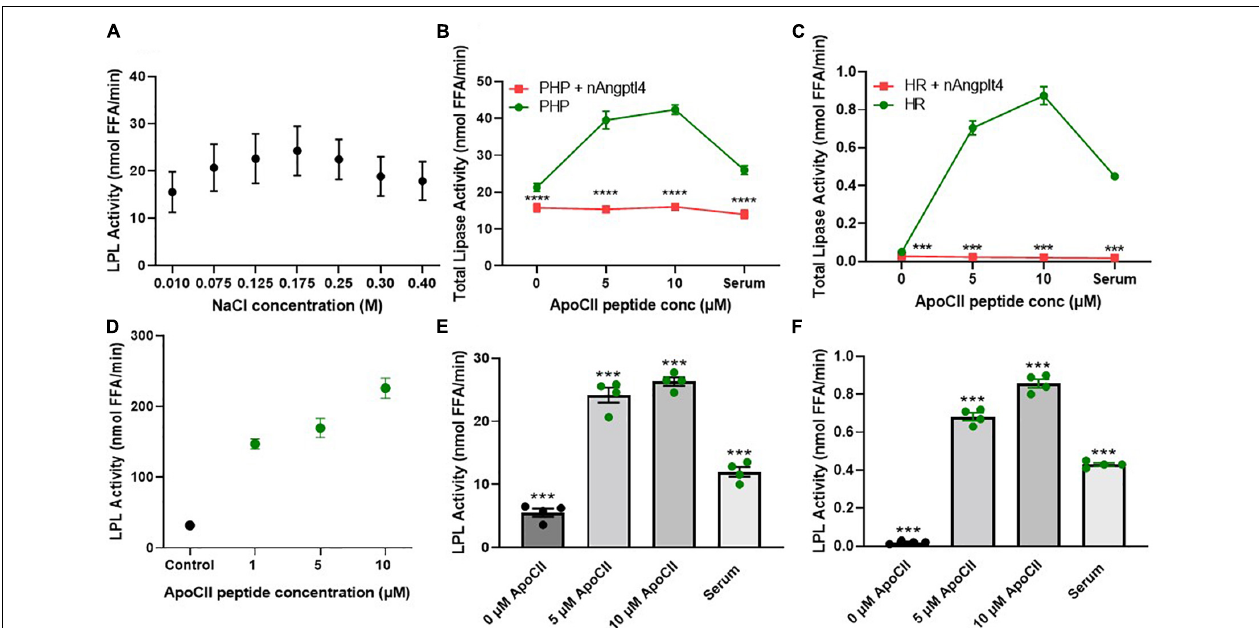
FIGURE 3 | NaCl, inhibitor (nAngptl4) and activator (ApoC-II peptide) standardization of the triolein substate method of measuring LPL activity. (A) Optimization of NaCl concentrations within KRP buffer used to dilute PHP (1:100) isolated from pool of healthy subjects. (B) Total lipase activity in PHP (1:100 dilution in 0.175 M NaCl KRP) + and – 5 µ g/mL nAngptl4 in presence of 0, 5, or 10 µ M ApoC-II peptide. (C) Total lipase activity in HR + and – 5 µ g/ml nAngptl4 in presence of 0, 5, or 10 µ M ApoC-II peptide. (D) Activation of bLPL with increasing ApoC-II peptide concentration. (E) LPL activity in PHP with increasing concentrations of ApoC-II peptide compared to serum as a source of ApoC-II. (F) LPL activity in KH with increasing concentrations of ApoC-II peptide compared to serum as a source of ApoC-II. *** P < 0.001; **** P <